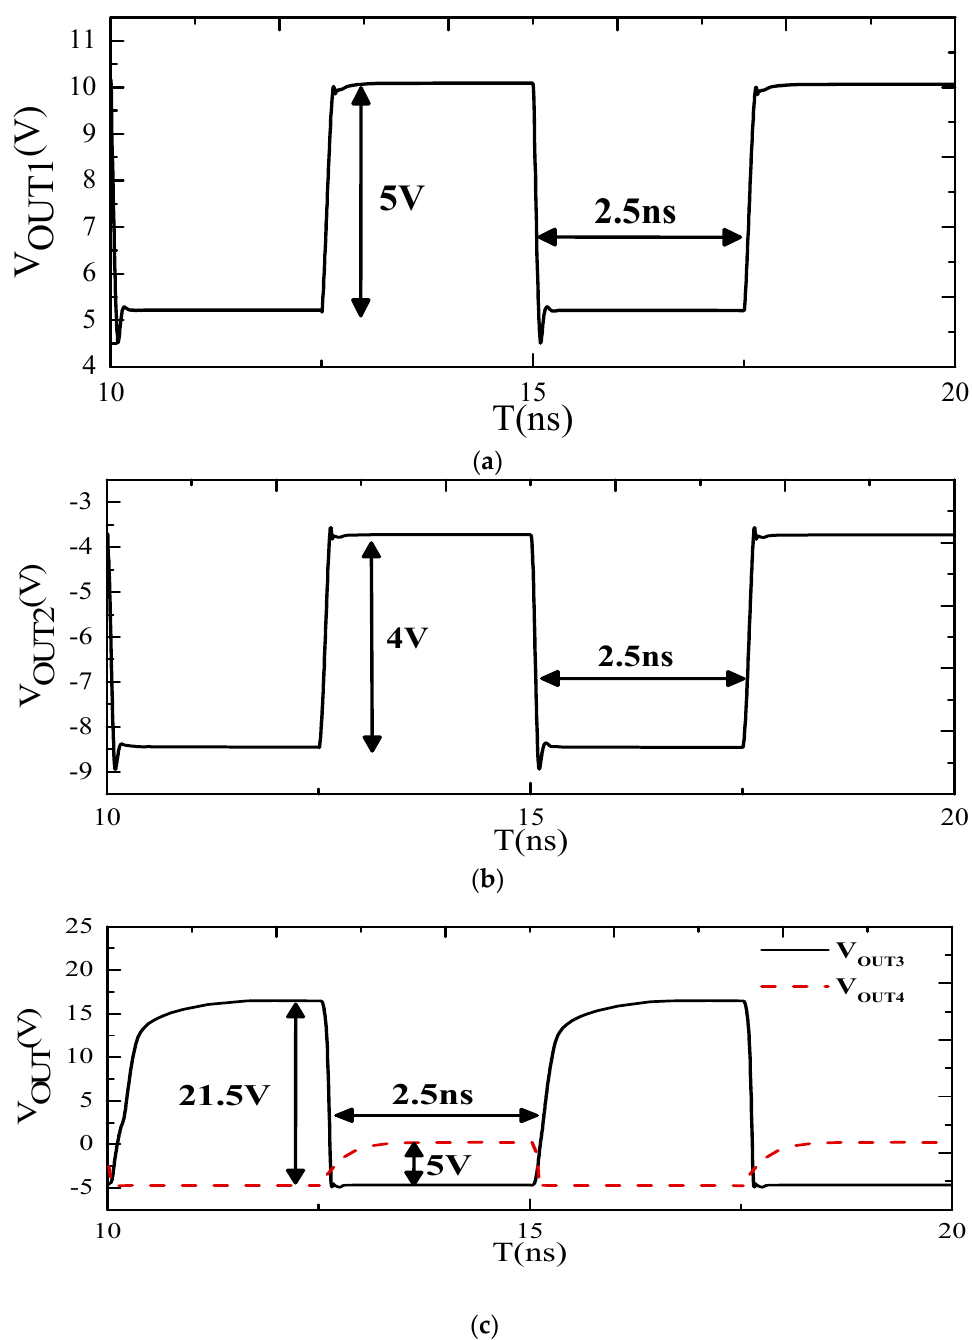
Figure 4. The simulated output waveform: ( a ) 1st stage, ( b ) left side of the 3rd stage and ( c ) right side of the 3rd stage.